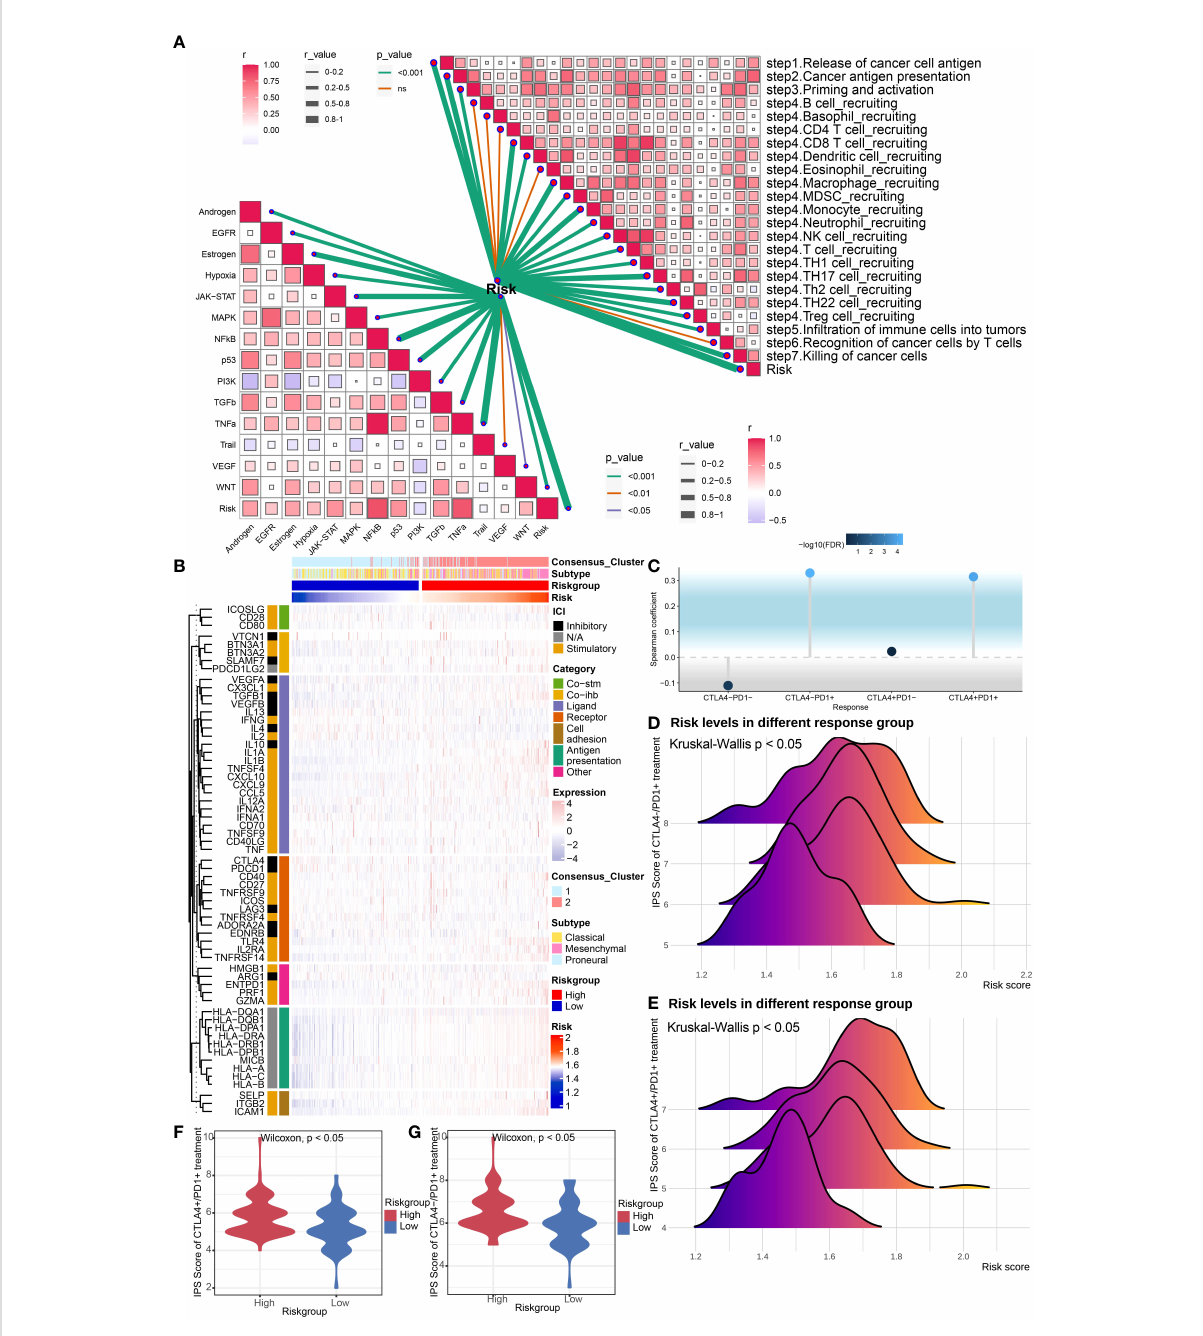
FIGURE 6 Evaluation of potential response to ICB treatment. (A) Correlation analysis of risk score and anti-cancer immunity cycle and 11 cancer related pathways. (B) Heatmap revealed immune associated gene expression levels in the TCGA Array dataset within the two risk groups. (C) The lollipop plot showed the correlation between risk core and ICB treatment response. (D, E) The ridgeline plots displayed the risk levels in the CTLA4-/PD1+ treatment group (D) and CTLA4+/PD1+ treatment group (E) . (F, G) The violin plots revealed IPS scores of high/low risk group in the CTLA4+/PD1+ treatment group (F) and CTLA4-/PD1+ treatment group (G) . P < 0.05, statistically signi fi